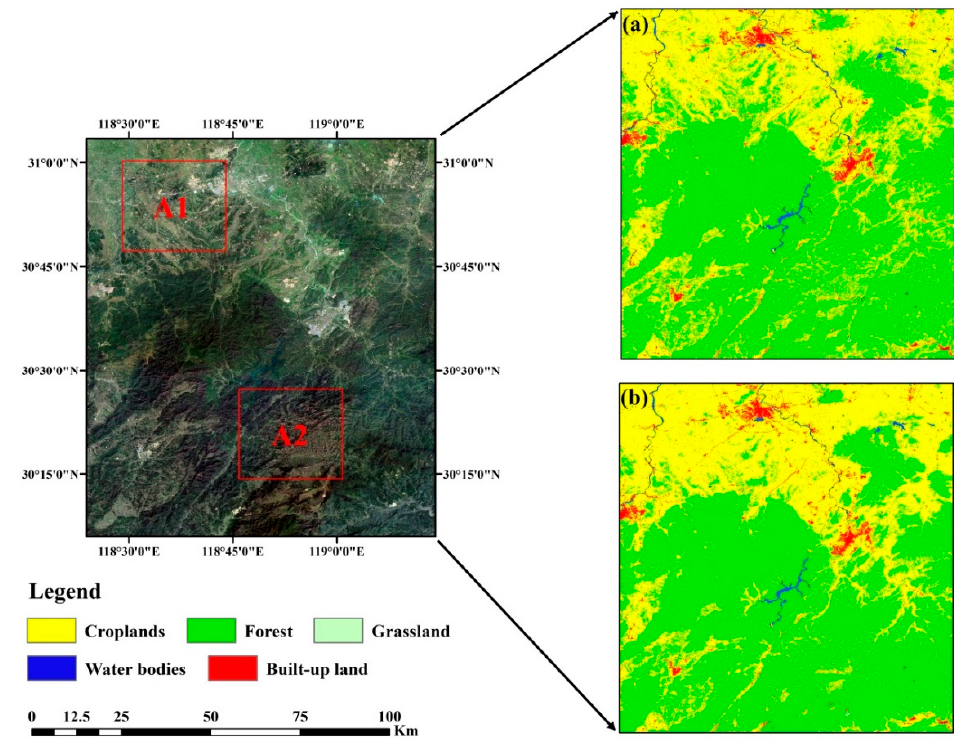
Figure 8. Comparison of all the feature classification results of the pixel- and object-based models. The image on the left is a Landsat-8 OLI true color composite with the A1 and A2 areas. ( a ) Result of the all features classification of the pixel-based model. ( b ) Result of the all features classification of the object-based model.